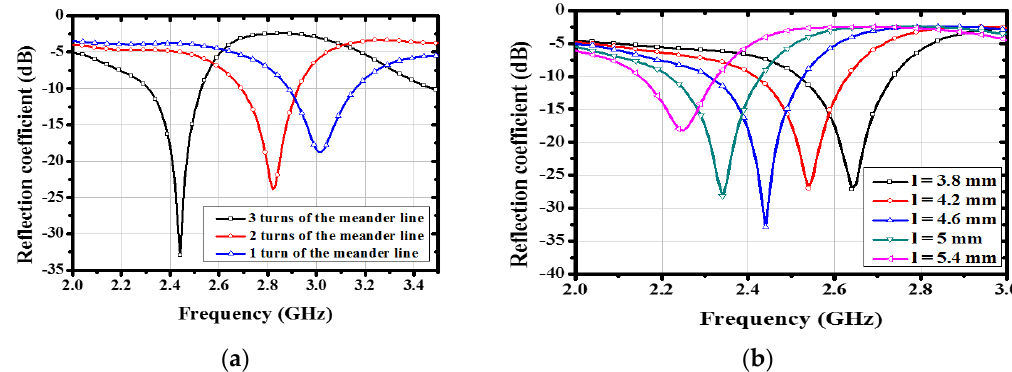
Figure 5. Meander line resonator with band pass characteristics: ( a ) Geometry of the meander line structure and ( b ) S-parameter characteristics.